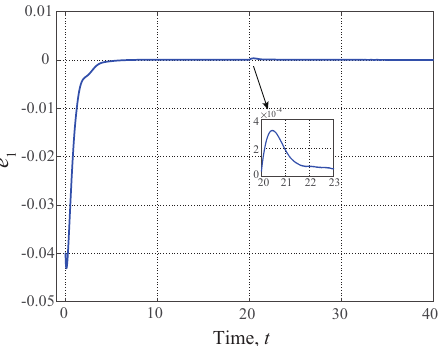
Figure 7. System response of e 1 under the external disturbances.